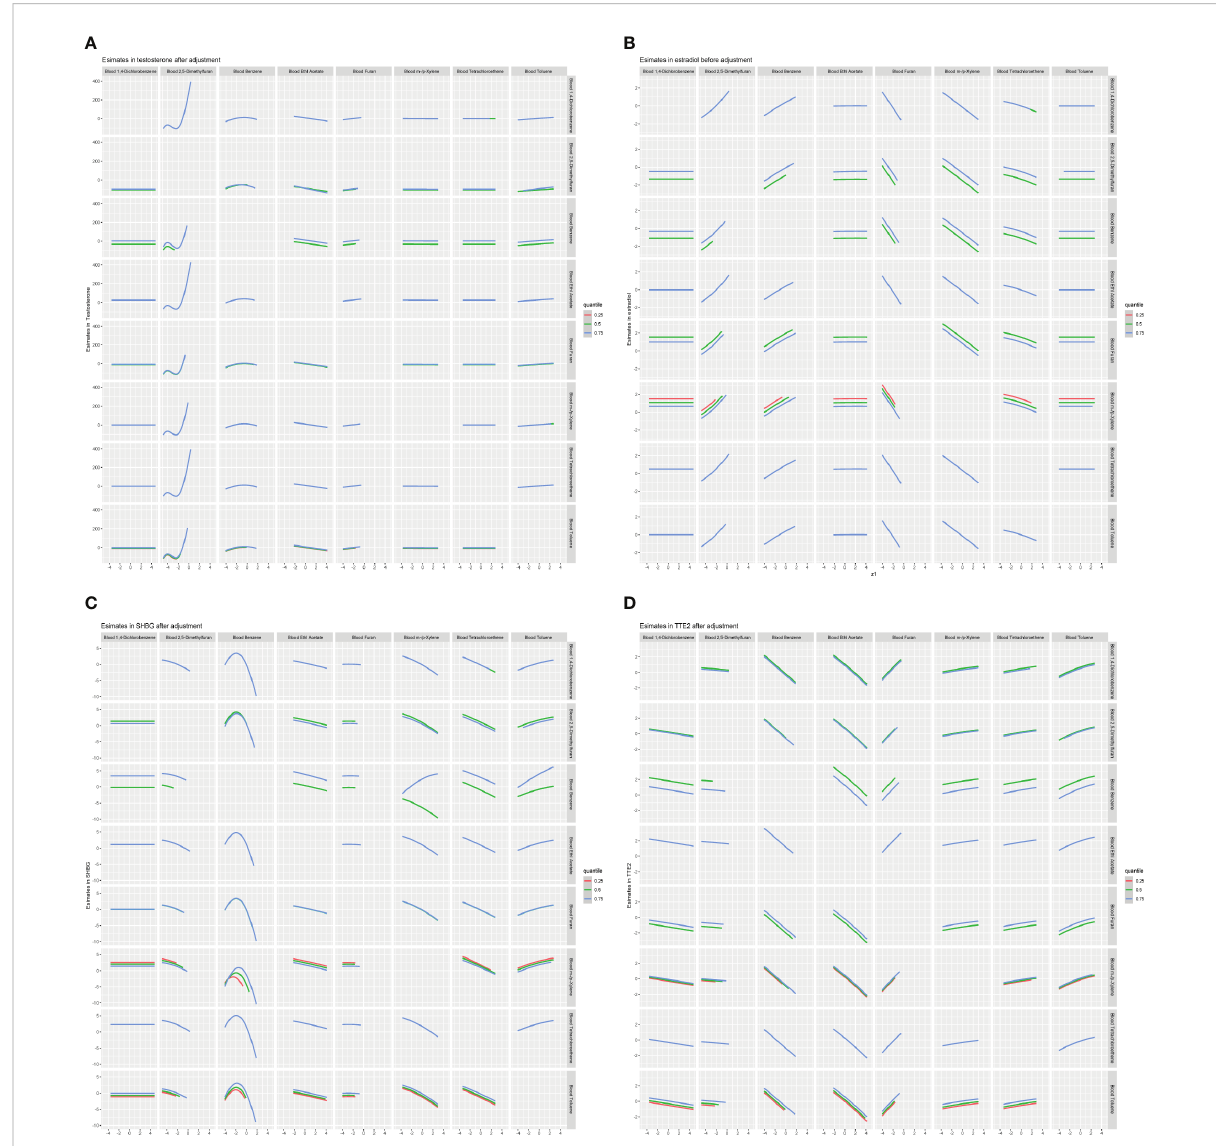
FIGURE 8 Bivariate exposure-response relationship between VOCs and sex hormones. (A) Models of blood VOCs and male testosterone. (B) Models of blood VOCs and male estradiol. (C) Models of blood VOCs and male SHBG. (D) Models of blood VOCs and male TT/E2. Each VOCS presented on the upper coordinate axis and sex hormones index when the corresponding VOCs on the right longitudinal are axis fi xed at the 25th, 50th, and 75th percentiles and the remaining metals are held at the 50th percentiles. Models adjusted for adjusts for age, race, education, marital status, body mass index (kg/m2), family income to poverty ratio, smoking and